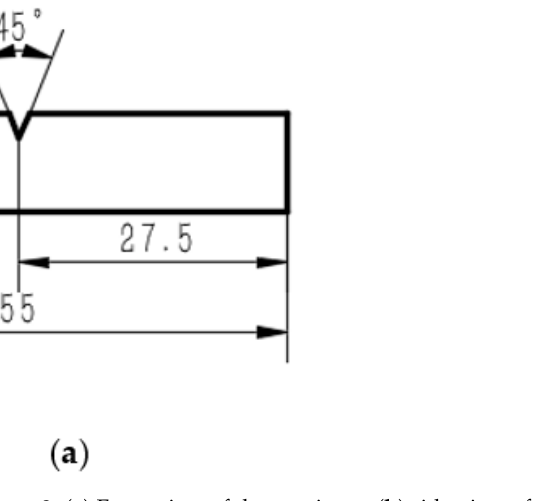
Figure 3. ( a ) Front view of the specimen; ( b ) side view of the